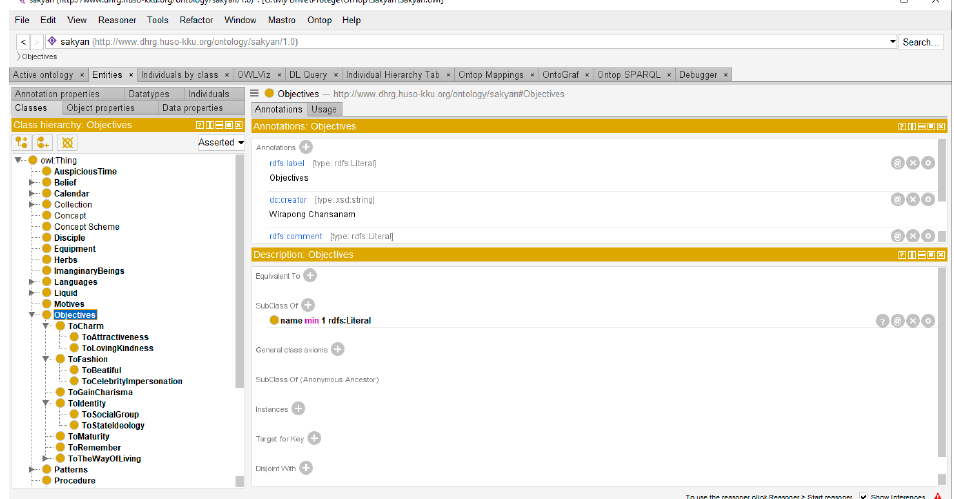
Figure 2. Classes and subclasses of Sak Yan ontology.